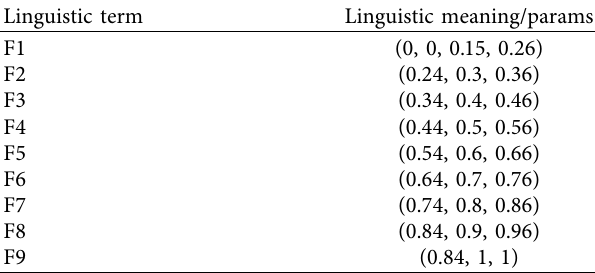
Table 2: FIO 2 linguistic terms used. Linguistic term